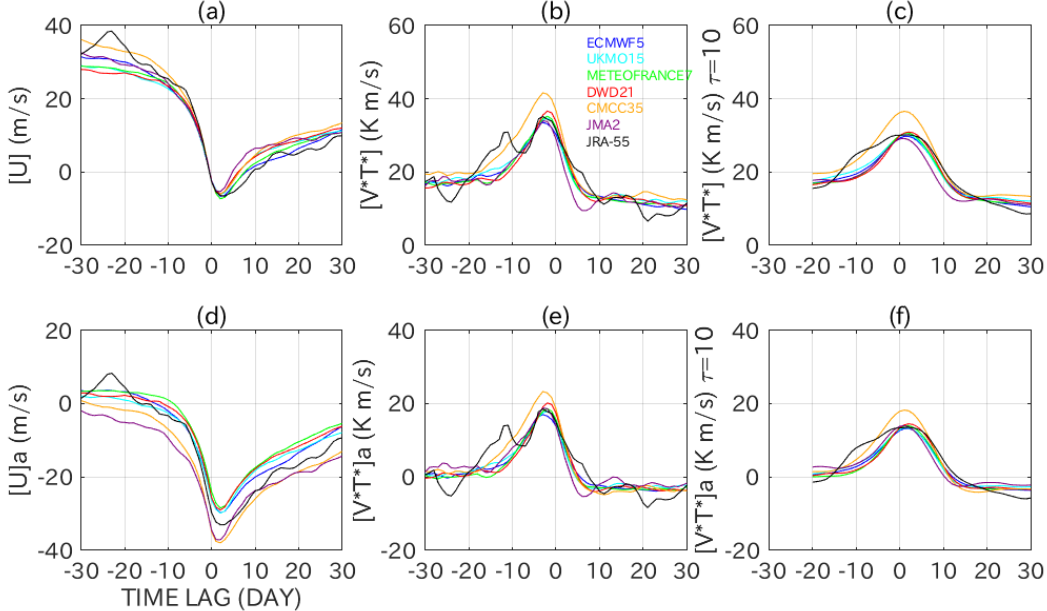
Figure 2. Ensemble means of composite time series with respect to the MSSW central date (lag = 0 day) for the HC and JRA-55 data: ( a ) zonal mean zonal wind at 60° N, 10 hPa, and ( b ) poleward heat flux of waves 1–3 in 45–75° N, 100 hPa, and ( c ) time mean of the heat flux. The time mean of the heat flux for each day is taken for 11 days from 10 days before the day to it (i.e., τ = 10 days). The composites are taken for the MSSWs in each ensemble member, and the results are averaged across the members. Panels ( d – f ) are for anomalies of the three quantities. Color legend is shown in ( b ). Asterisk denotes wave components, i.e., deviations from the zonal mean. Separate contributions from wave 1 and wave 2 to the increased heat flux are